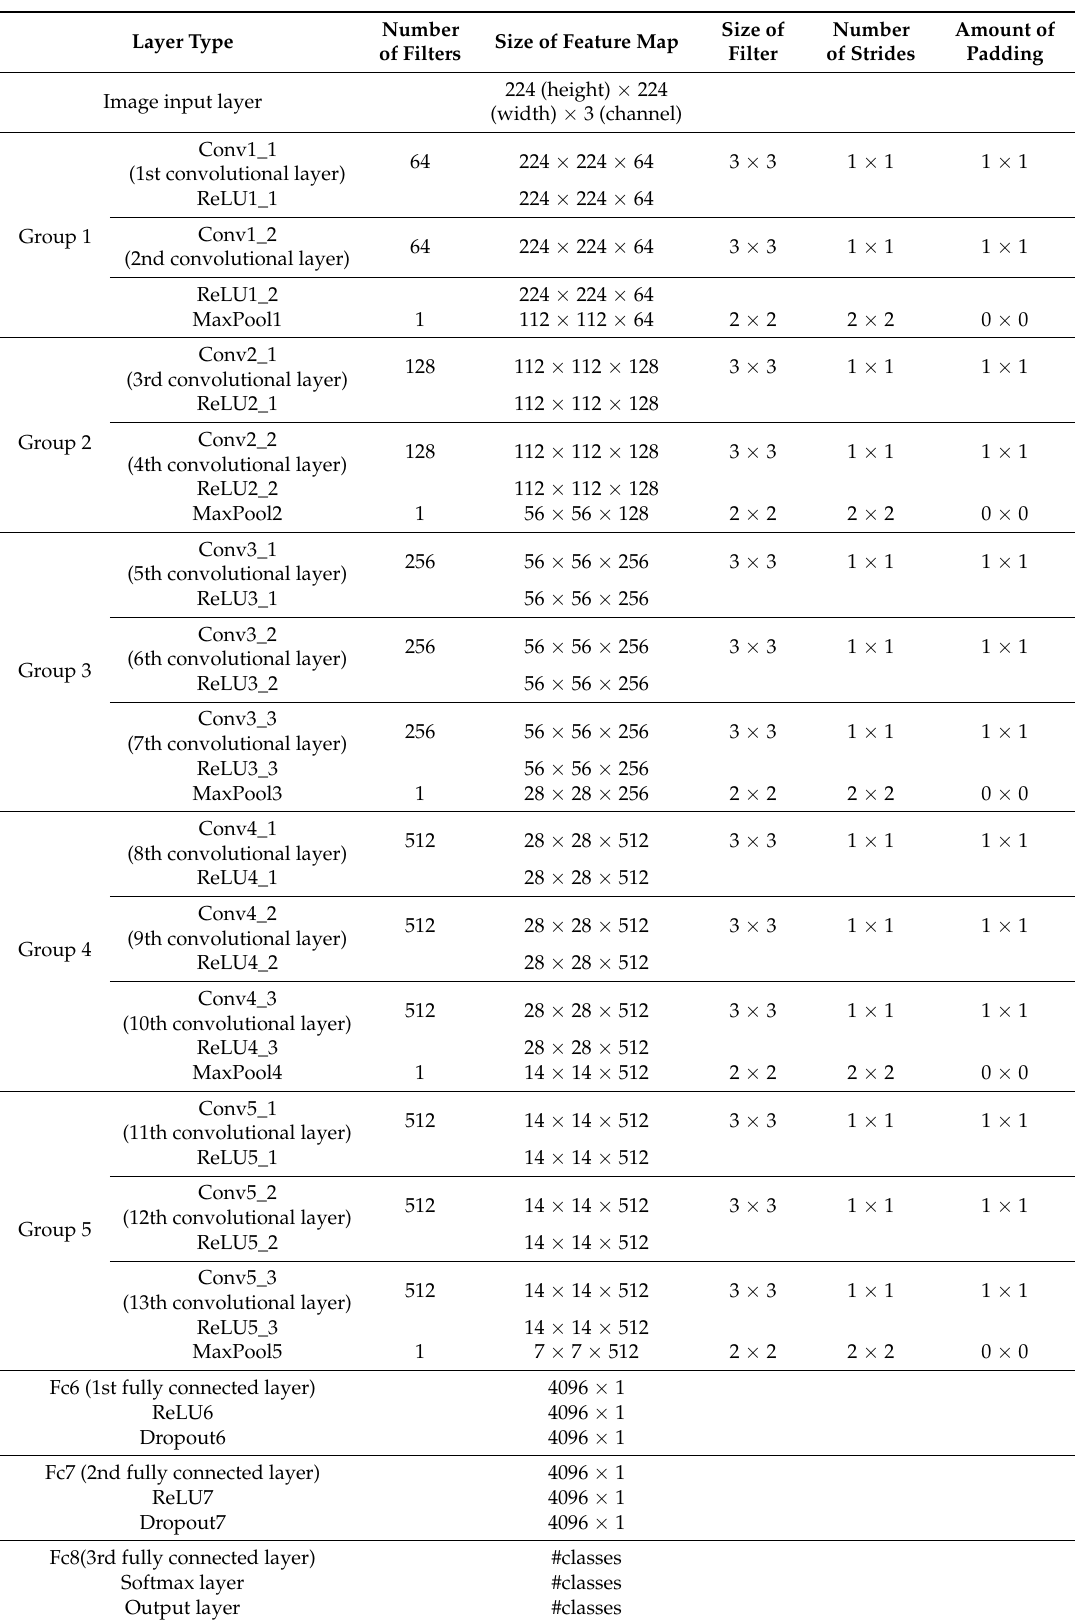
Table 2. Descriptions of VGG Face-16